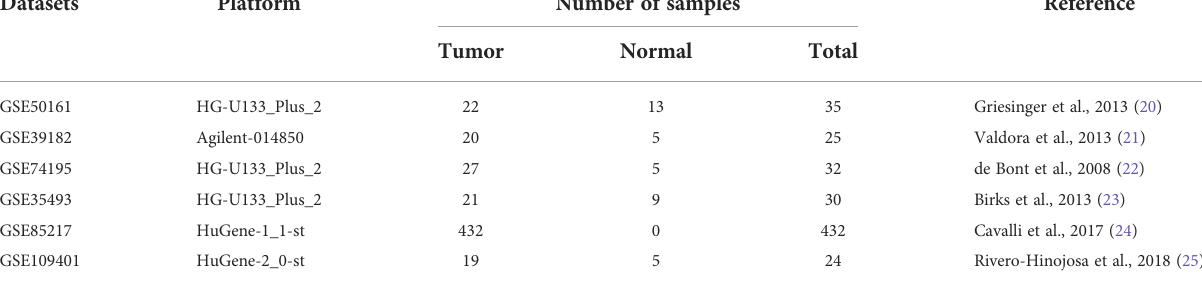
TABLE 1 Details of selected GEO datasets in this